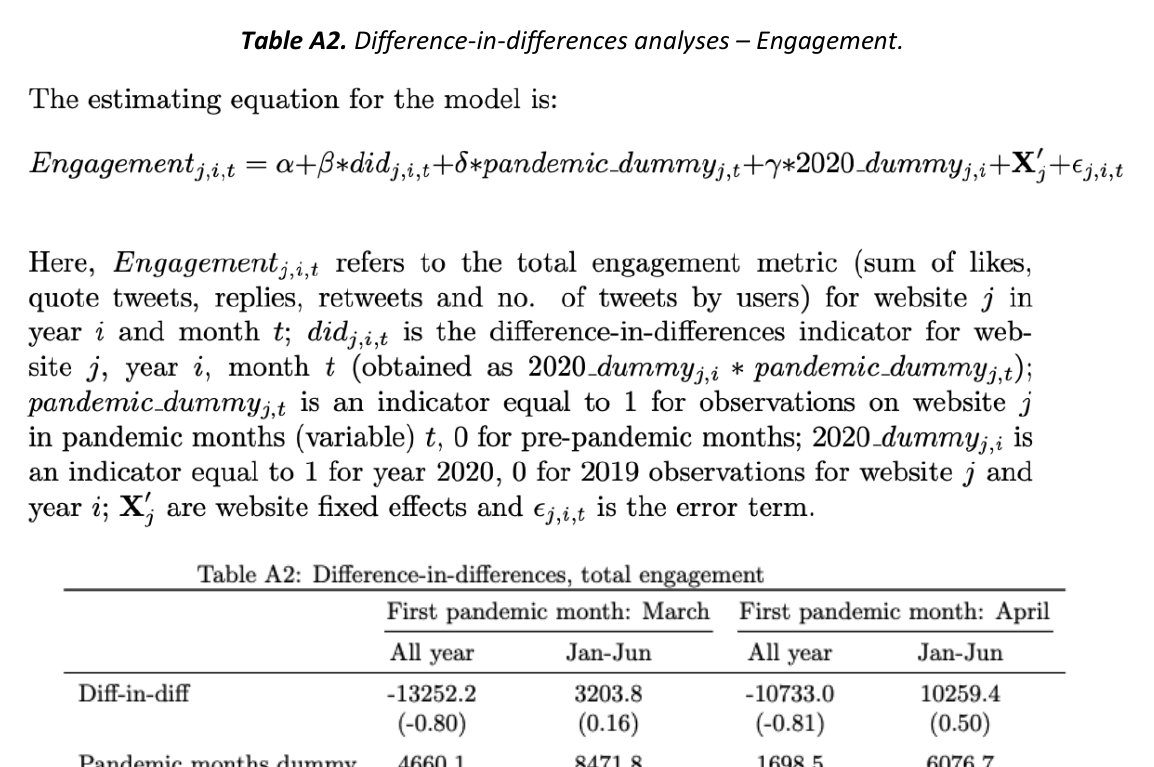
Table A2. Difference-in-differences analyses –